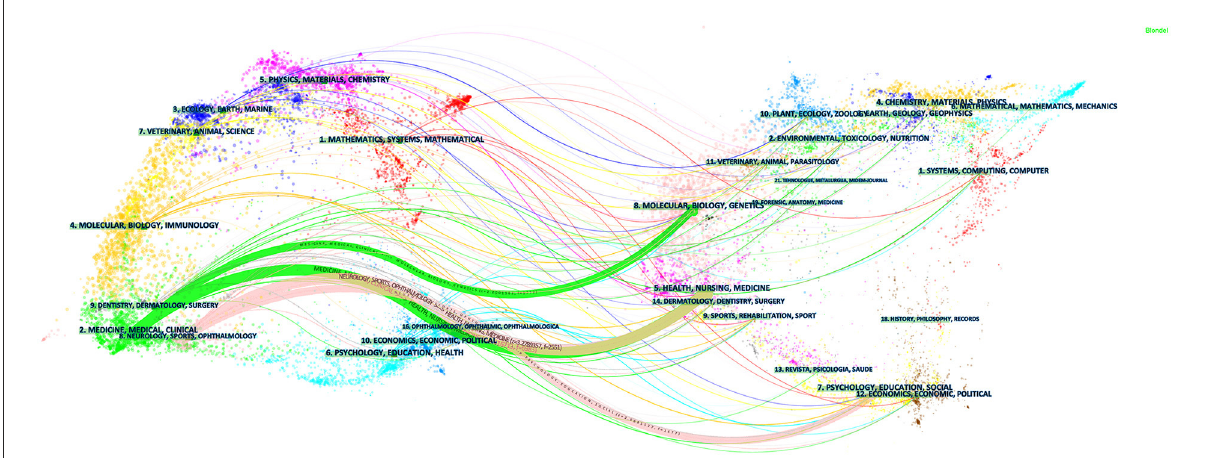
FIGURE5 A dual-map overlay of the science mapping literature. The citing journals are on the left, the cited journals are on the right, and the colored path represents the citation relationship. Citation trajectories are distinguished by citing regions’ colors. The thickness of these trajectories is proportional to the z-score-scaled frequency of citations.